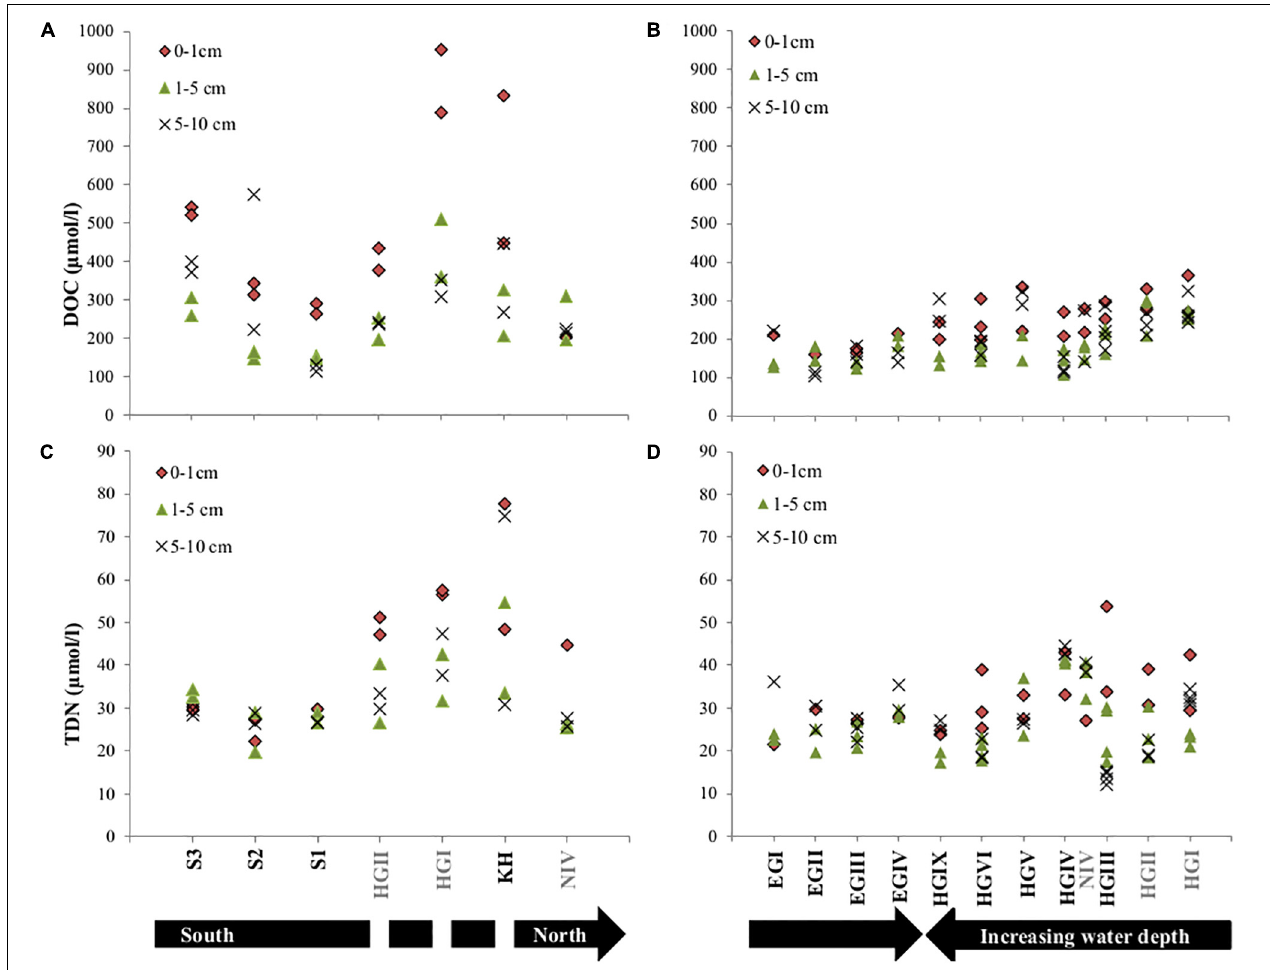
FIGURE 3 | Concentrations of dissolved organic carbon (DOC) and total dissolved nitrogen (TDN) in all analyzed porewaters for the years 2013 (A,C) and 2014 (B,D) . Note that sampling in 2013 displays latitudinal variations and 2014 longitudinal trends. The discontinuity in the black arrow in (C) , indicates that HGII, HGI, KH are at a similar latitude. Stations written in gray font were sampled in both